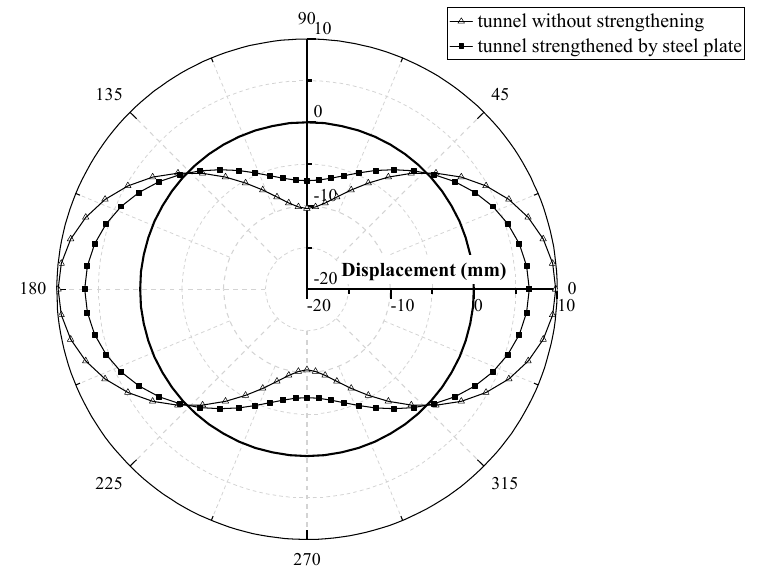
Figure 10. Comparison of lining radial displacement between tunnels with and without steel plate strengthening.